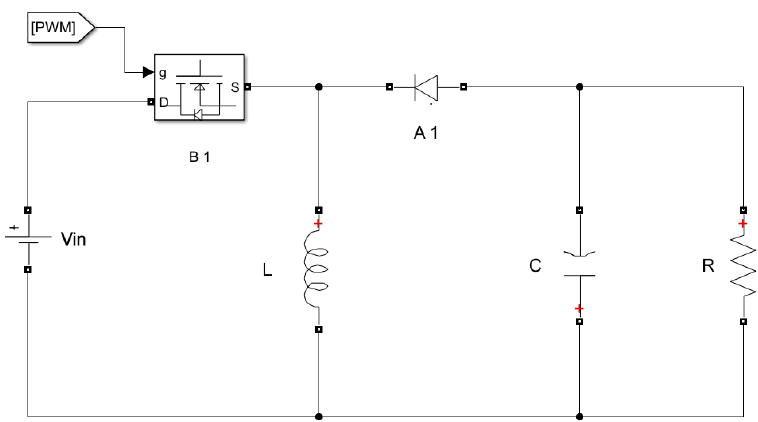
Table 3. Characteristics of the buck – boost converter